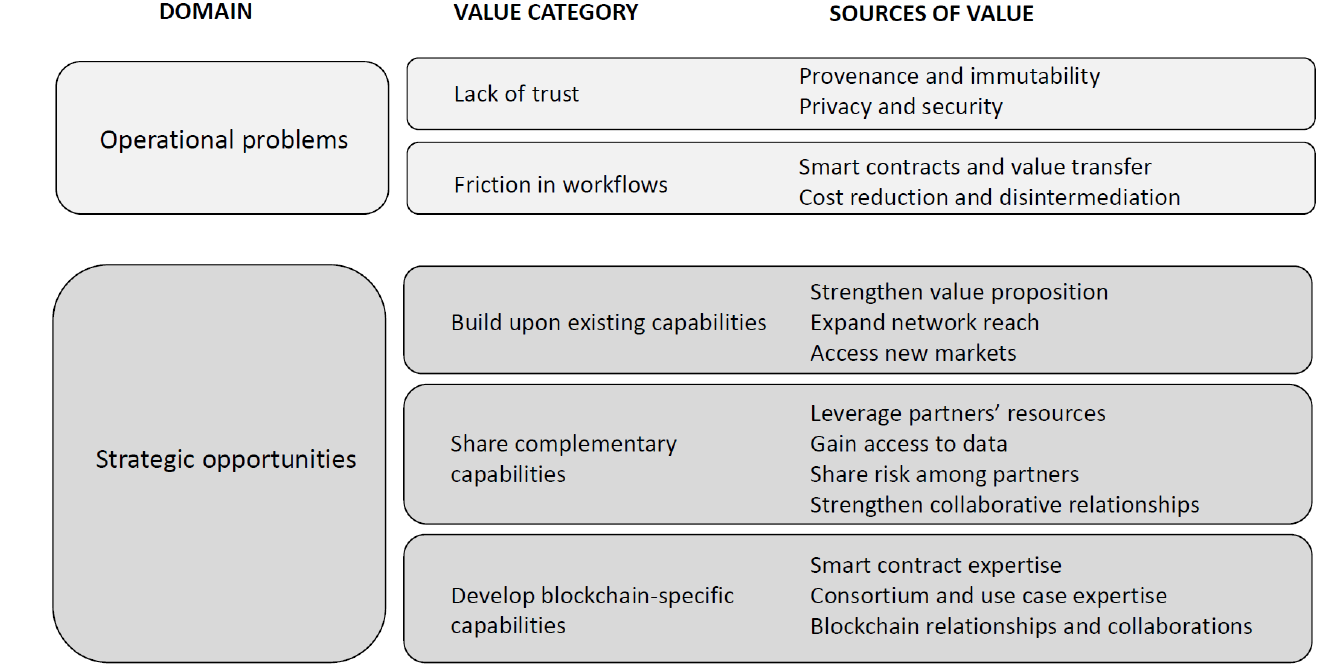
Figure 1: Blockchain Strategic Opportunities and Unexplored Sources of